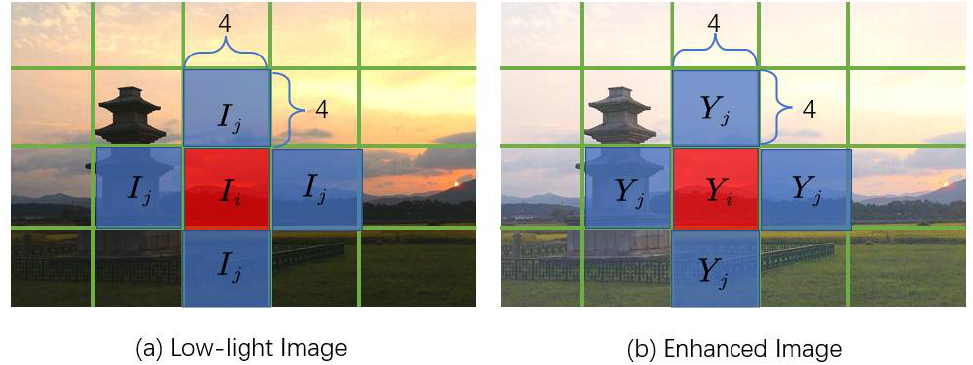
Figure 4. Mapping of spatial consistency loss. Subfigure ( a , b ) respectively show the setting of local regions in the original image and the enhanced image Exposure Control Loss is used to control the exposure level.